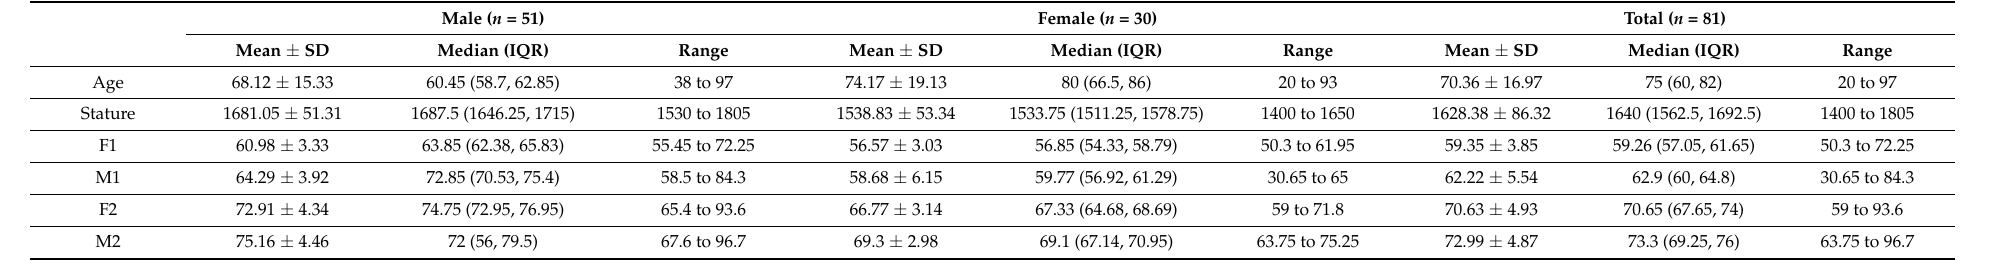
Table 1. Summary statistics (Mean, standard deviation, median and range) of age, stature, F1 (first metatarsal physiological length, M1 (first metatarsal maximum length), F2 (second metatarsal physiological length) and M2 (second metatarsal maximum length) measurements (mm) of both